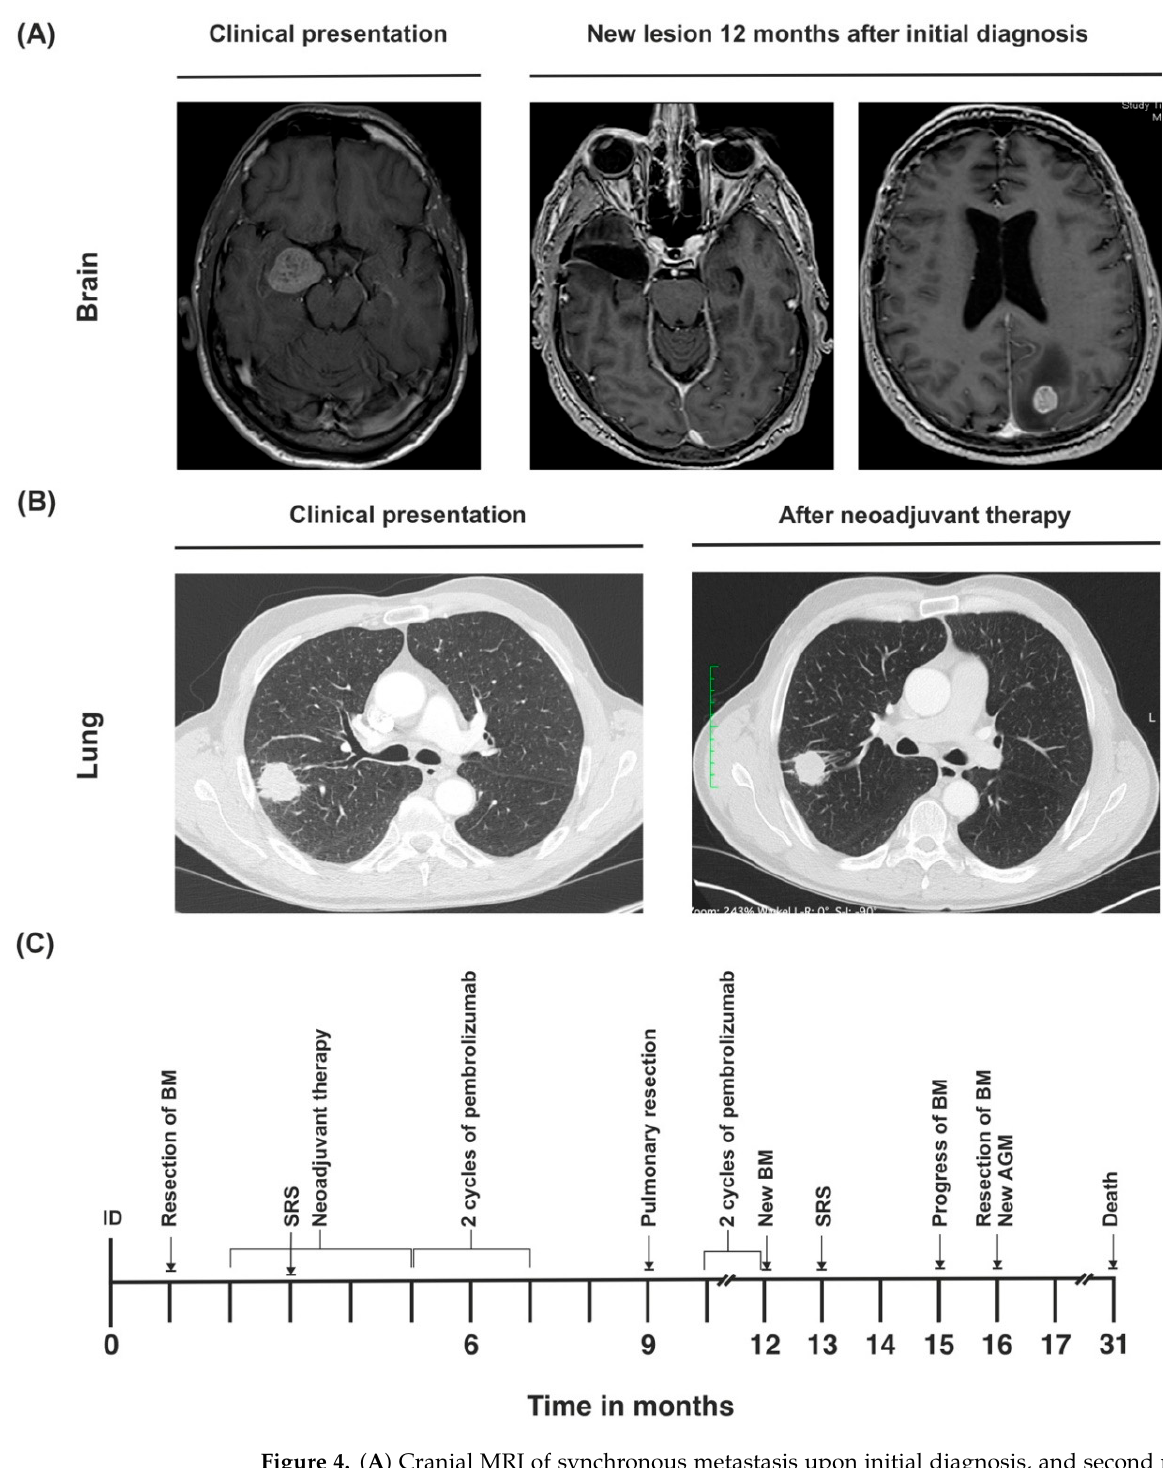
Figure 4. ( A ) Cranial MRI of synchronous metastasis upon initial diagnosis, and second metastasis that developed during the course of disease. ( B ) Primary tumor at initial diagnosis and after neoadjuvant therapy. ( C ) Timeline of the patient’s treatment course. ID = initial